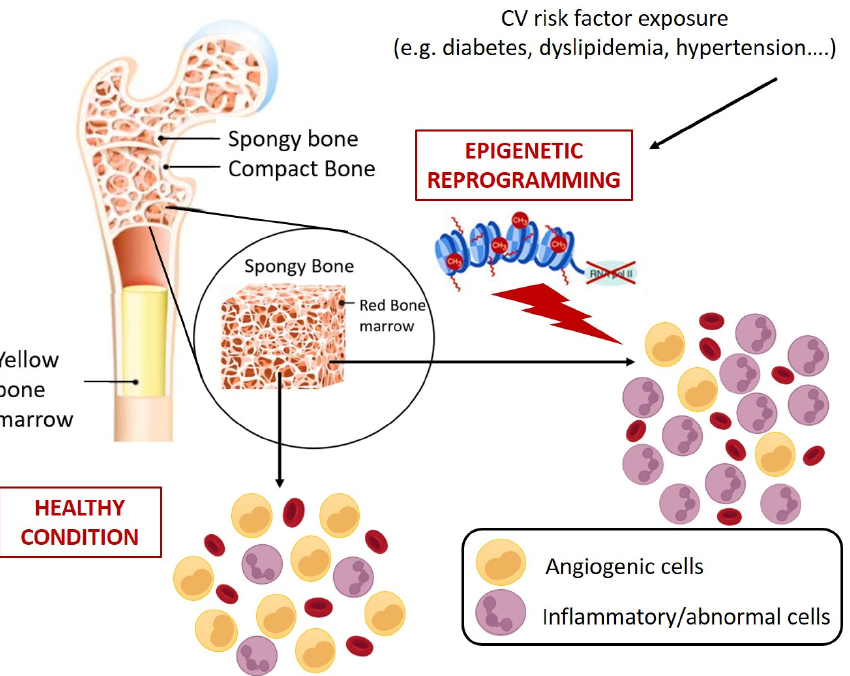
Figure 4. Schematic representation of CV risk-induced reprogramming of HSPCs at bone marrow level. CV risks promote epigenetic changes in HSPCs that results in abnormal expansion of cells with inflammatory and pro-atherosclerotic features. Specifically, monocytes characterized by more inflammatory phenotypes (e.g., alternative and non-classic monocytes) and generation of circulating progenitors with pro-calcific and pro-fibrotic characteristics [119–124].